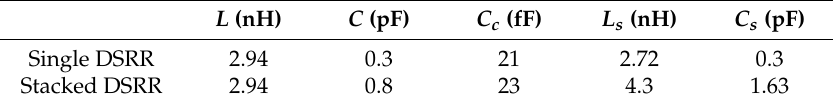
Table 1. Extracted parameters for the circuit of Figure 3